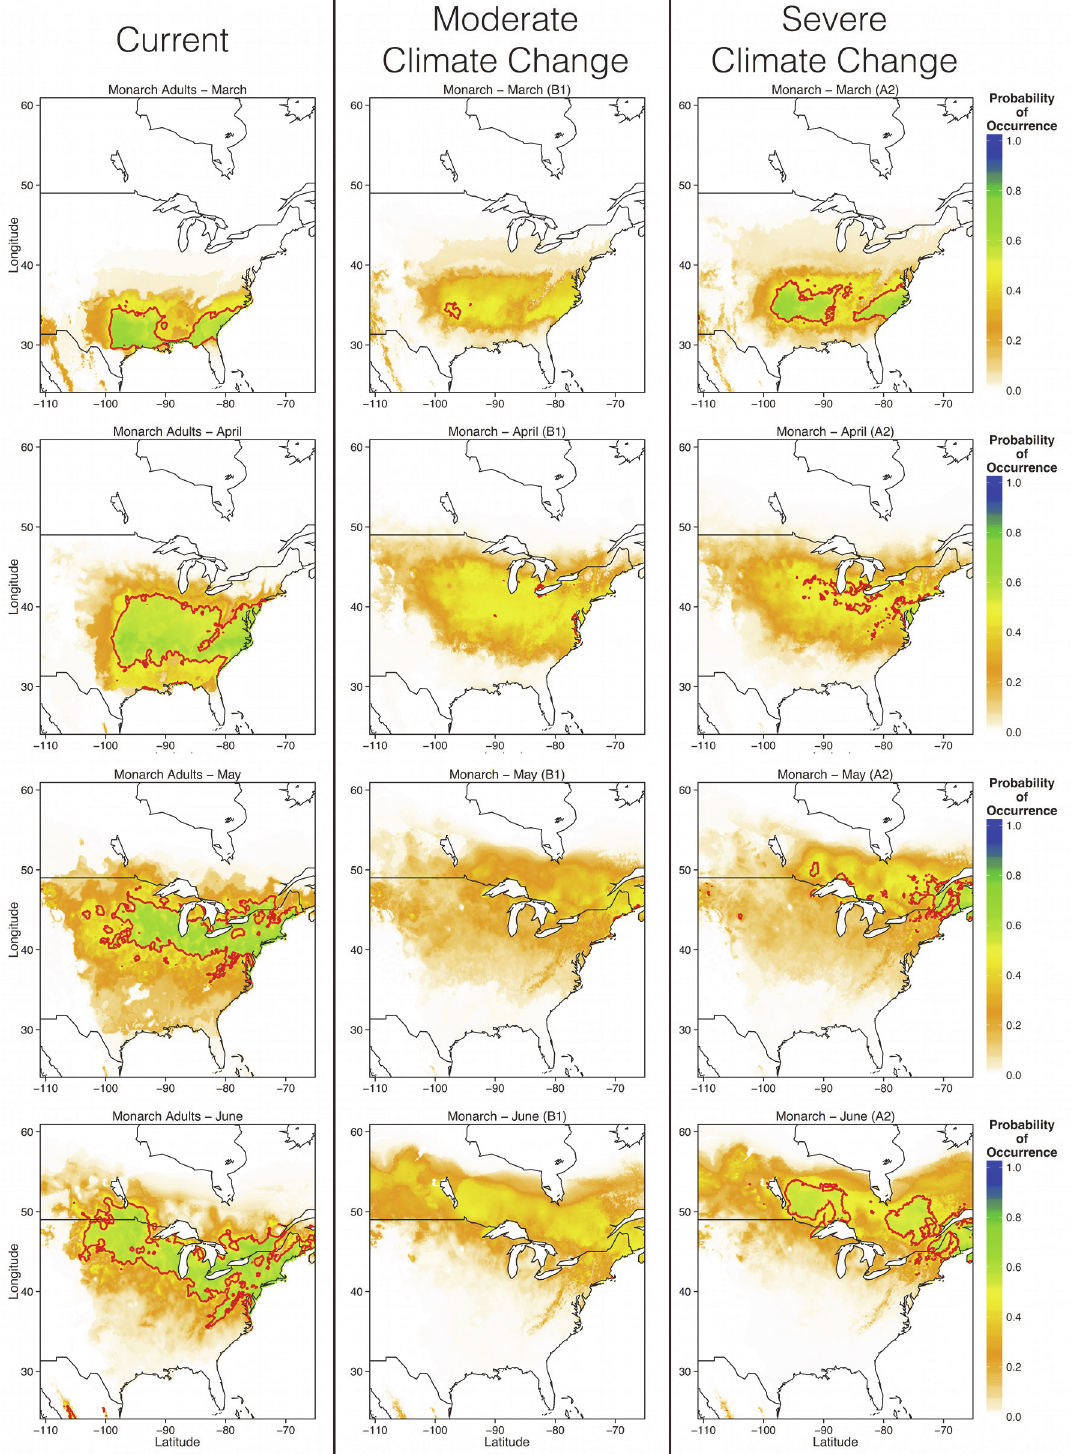
Fig 9. Ensemble projections of future monarch distributions during each of the spring months (March — June) under moderate and severe climate change scenarios. Ensemble projections were generated by averaging MaxEnt output from each of the four GCM